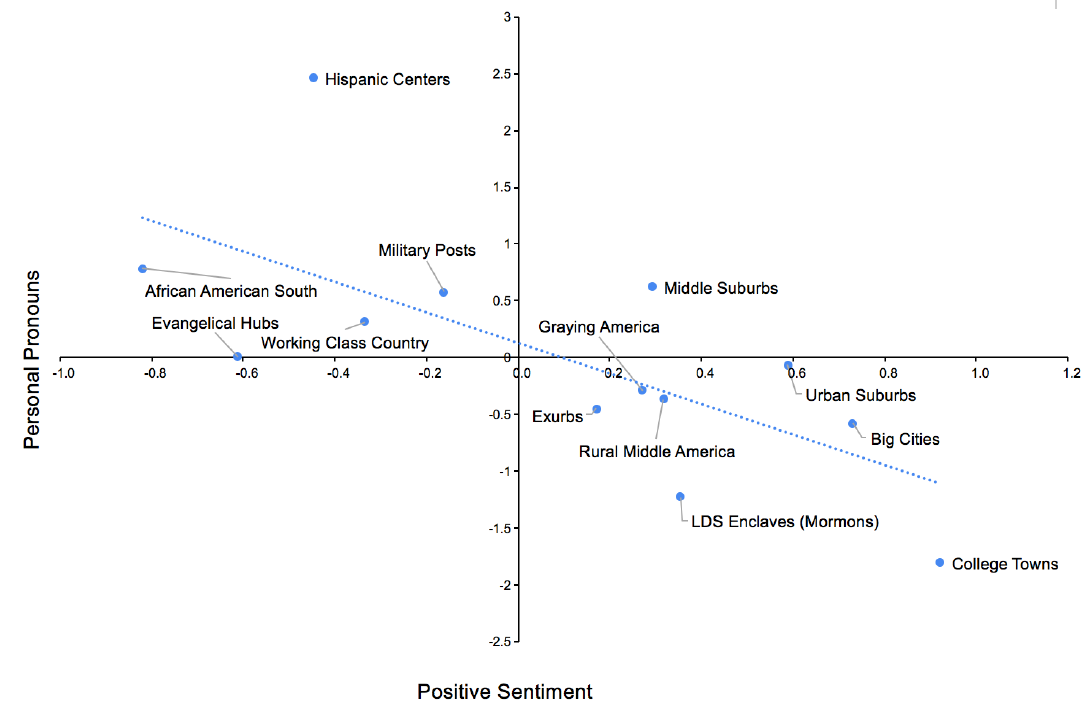
Figure 5. Scatter plot of personal (versus impersonal) tweeting against positive sentiment across the 14 ACP community types. Sentiment is based on the NRC positive sentiment model. Both dimensions were standardized.